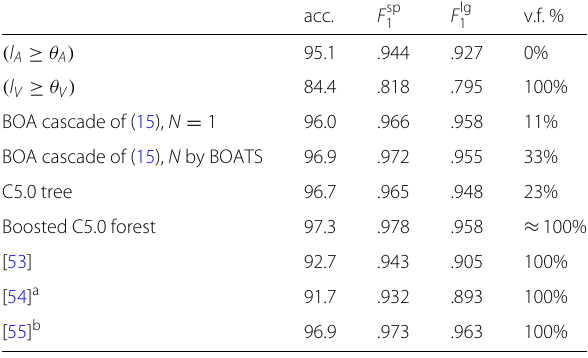
ComparisonoflaughterdetectorsonMAHNOBlaughterdata.Theusedmeasuresof performance are the overall accuracy, F 1 -scores for both speech ( F sp 1 ) and laughter